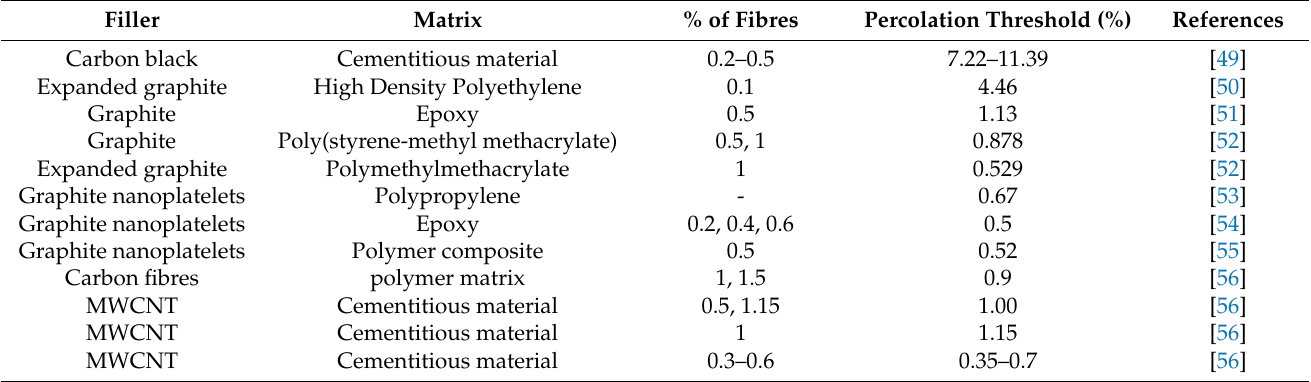
Table 5. Percolation thresholds for different filler materials with respect to their